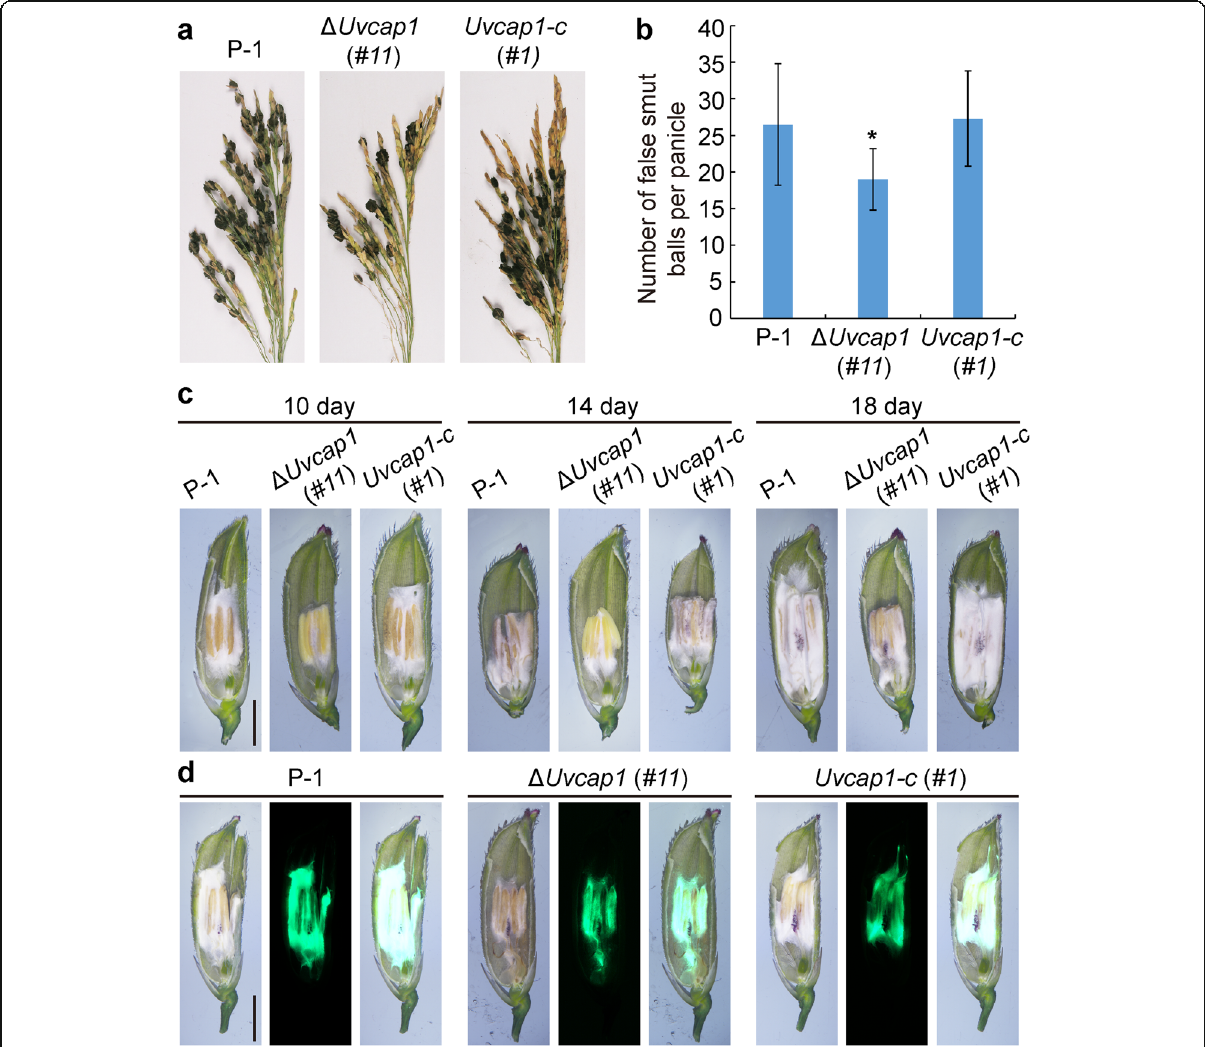
Fig. 3 UvCap1 is required for full virulence of U. virens . a The rice false smut balls generated by the wild-type strain P-1, the Δ Uvcap1 ( #11 ) mutant and its complemented strain Uvcap1-c ( #1 ). Pictures were taken at 30 dpi. b Column diagram showing the average numbers of false smut balls in an infected panicle in a. Error bars represent SD. * indicates significant differences between the mutant and the wild-type/or complemented strains as estimated by Duncan ’ s new multiple range test ( P <0.05). c Mycelial extension of P-1, Δ Uvcap1 ( #11 ) and Uvcap1-c ( #1 ) inside the spikelets at 10, 14 and 18 dpi. Bar, 10 μ m. d Mycelial extension of GFP-tagged P-1, Δ Uvcap1 ( #11 ) and Uvcap1-c ( #1 ) inside the spikelets at 10 dpi. Bar, 10 μ